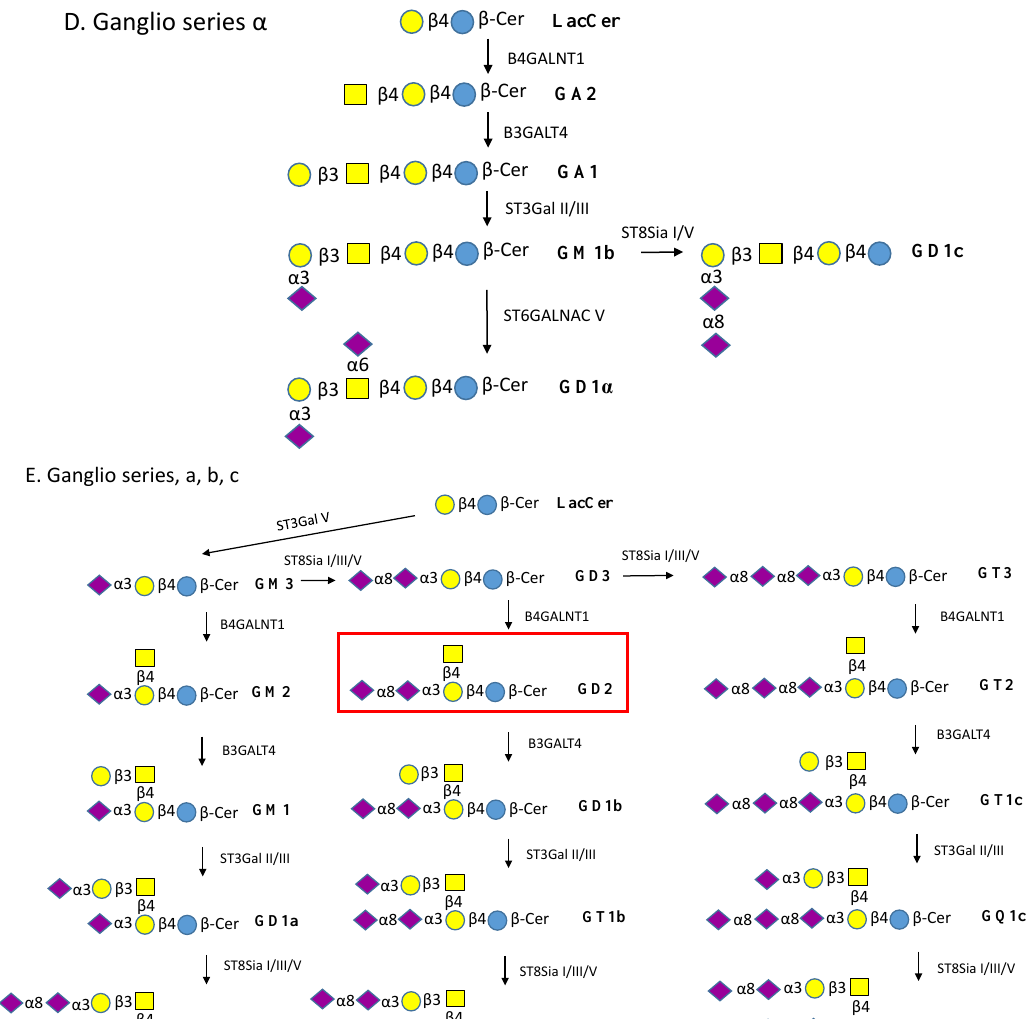
Figure 1. Pathways of glycosphingolipid (GSL) biosynthesis. ( A ). Lacto series GSLs. Lactosylceramide (LacCer) is the common intermediate for lacto, globo and ganglio series GSLs. The lacto series GSLs can have numerous di ff erent extensions and can carry glycan epitopes and antigens. Addition of GlcNAc to LacCer produces the precursor to all neo-lacto series GSLs, known as lactotriaosylceramide (Lc3). Lc3 is extended by the substitution of GlcNAc by a Gal β 1-4 residue. The names of enzymes involved are indicated near the arrows. ( B ). Gal-ceramide series GSLs. Gal is added to ceramide by Cer- β -Gal-transferase UGT8 and reaction product GalCer can then undergo at least three di ff erent substitutions. ( C ). Globo series GSLs. The globosides are first produced by substitution of the Gal residue of LacCer with a Gal α 1-4 residue to yield globotriaosylceramide (Gb3). Addition of GalNAc in β 1-3 linkage to Gb3 forms globotetraosylceramide (Gb4). The iso-globo series contains Gal α 1-3 instead of Gal α 1-4. ( D ). Ganglioseries- α GSLs. LacCer is the precursor for neutral GSLs, GA2 and GA1, and for all gangliosides. The addition of sialic acid in α 2-6 linkage to GalNAc forms the α series of compounds. Here we show the synthesis of GD1 α from GM1b. ( E ). Ganglio series a, b and c GSLs. The GM3 synthase ST3GAL V adds a sialic acid in α 2-3 linkage to the Gal residue of LacCer to form GM3. The series that carries one sialic acid on Gal β 1-4 is named ganglio a-series. Gangliosides having sialyl α 2-8sialyl α 2-3 substitutions are name ganglio b-series. The c-series have sialyl α 2-8sialyl α 2-8sialyl α 2-3 substitutions.